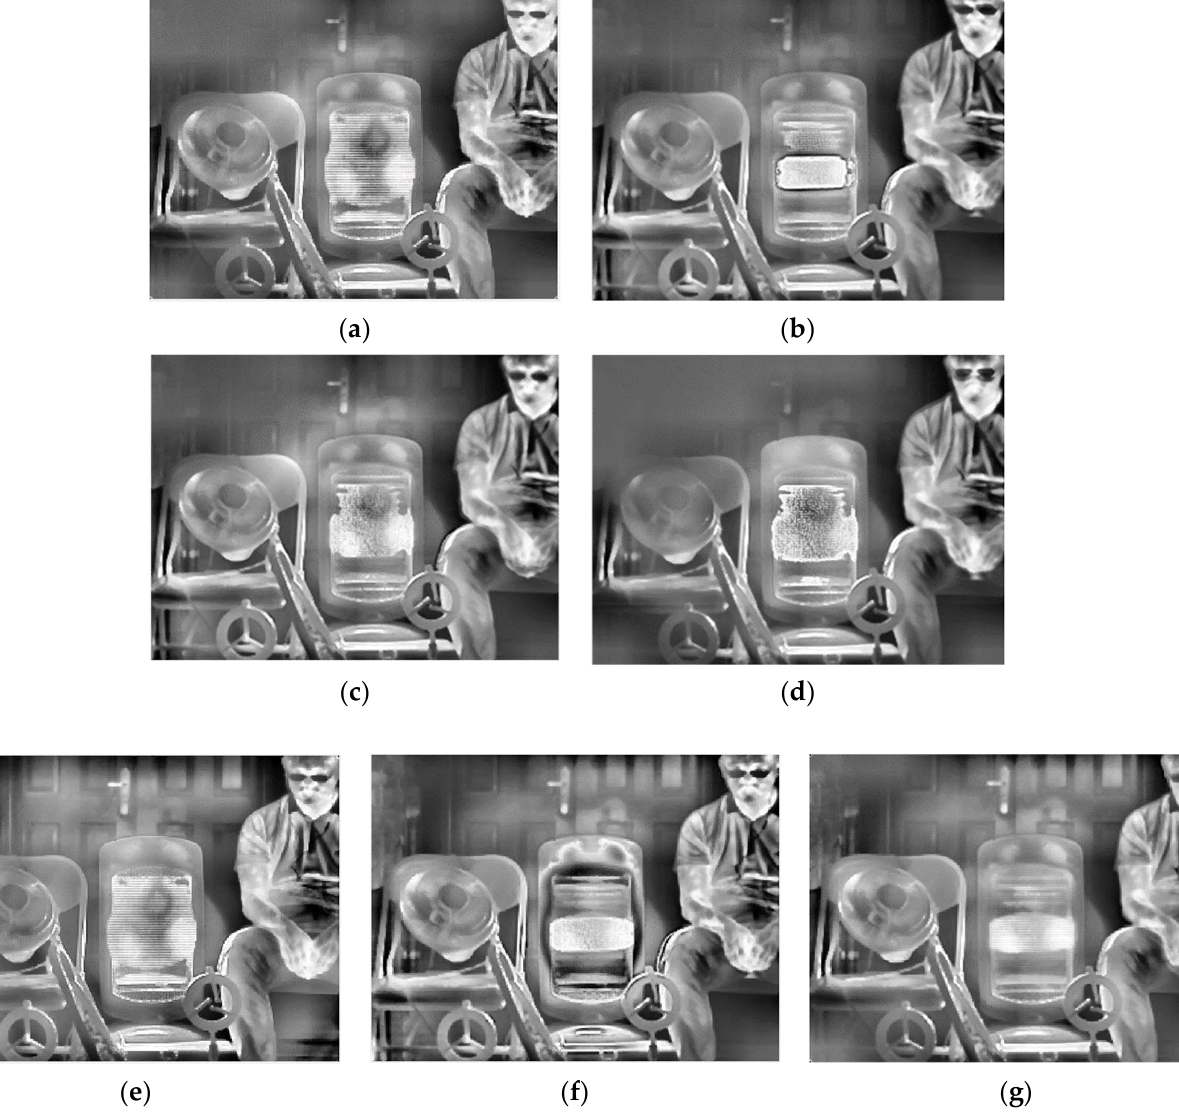
Figure 14. HDR fusion results for scene 2 with different selection methods: ( a ) single integration